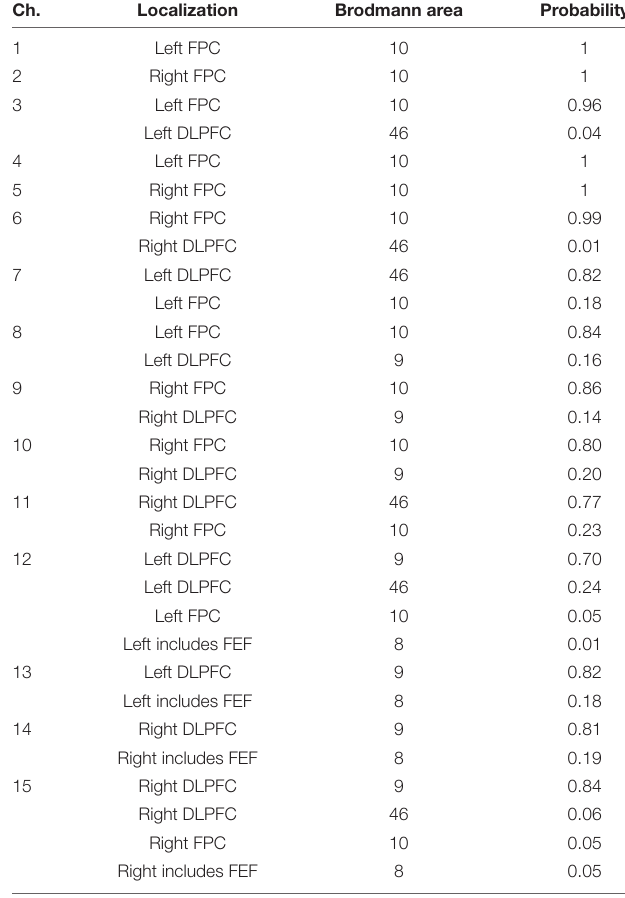
TABLE 1 | Spatial profiling of each recording